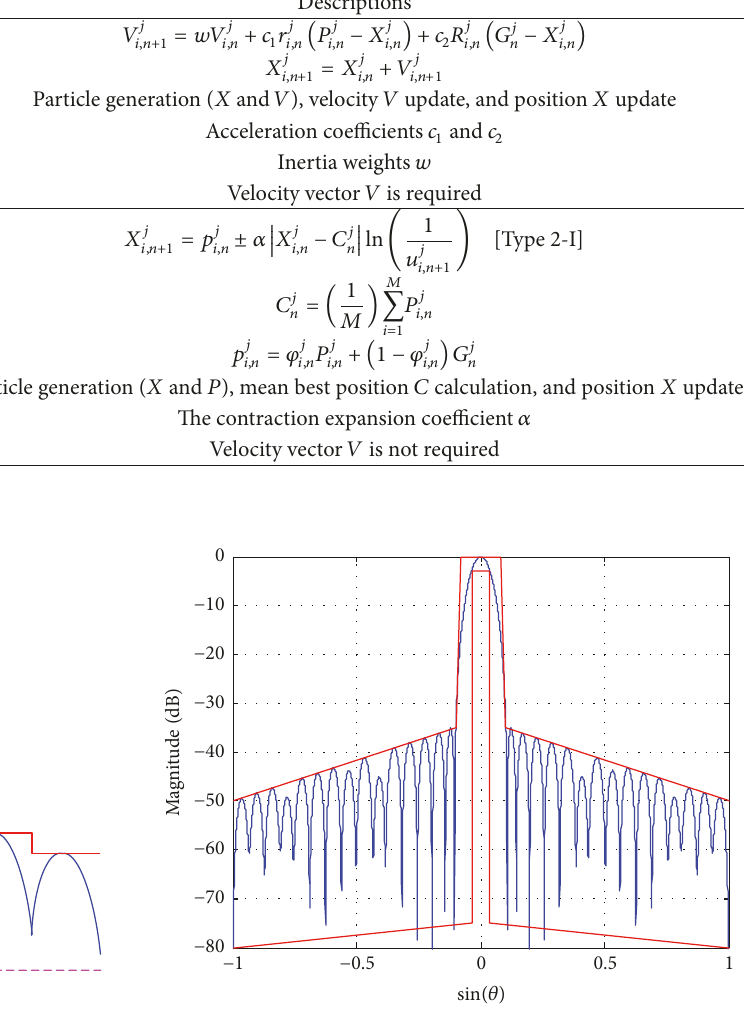
Figure 4: Cost function description for the synthesis of a linear array.